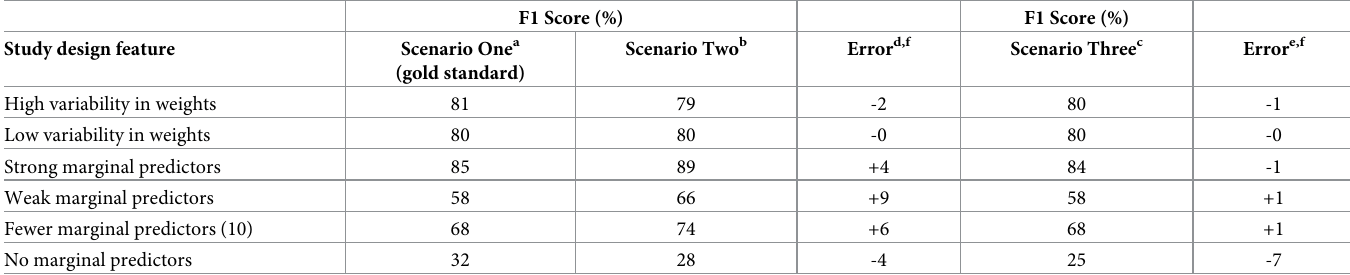
Table 3. Performance of gradient boosting models configured and evaluated under different analytic scenarios, holding sample size constant at N = 10,000. F1 Score (%) F1 Score (%)